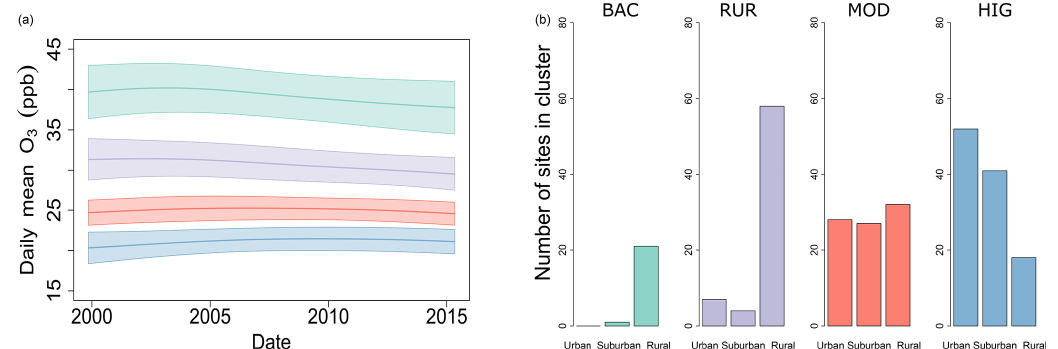
Figure 3. Clusters based on daily mean O 3 LT (t) . Average LT (t) in each cluster with the standard deviation (a) and histograms (b) for the site type included in each cluster.